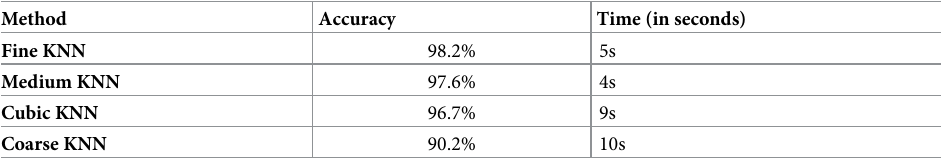
Table 1. Percentage error of alternative KNN algorithms.